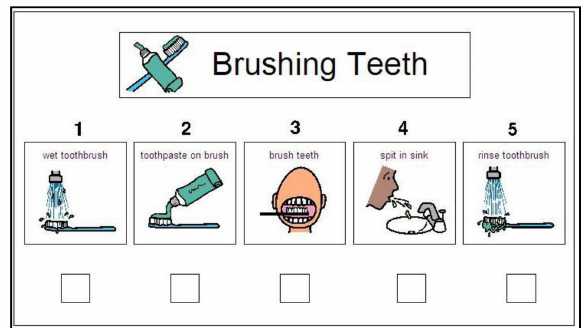
Figure 4. The regular dental visual aids: brushing